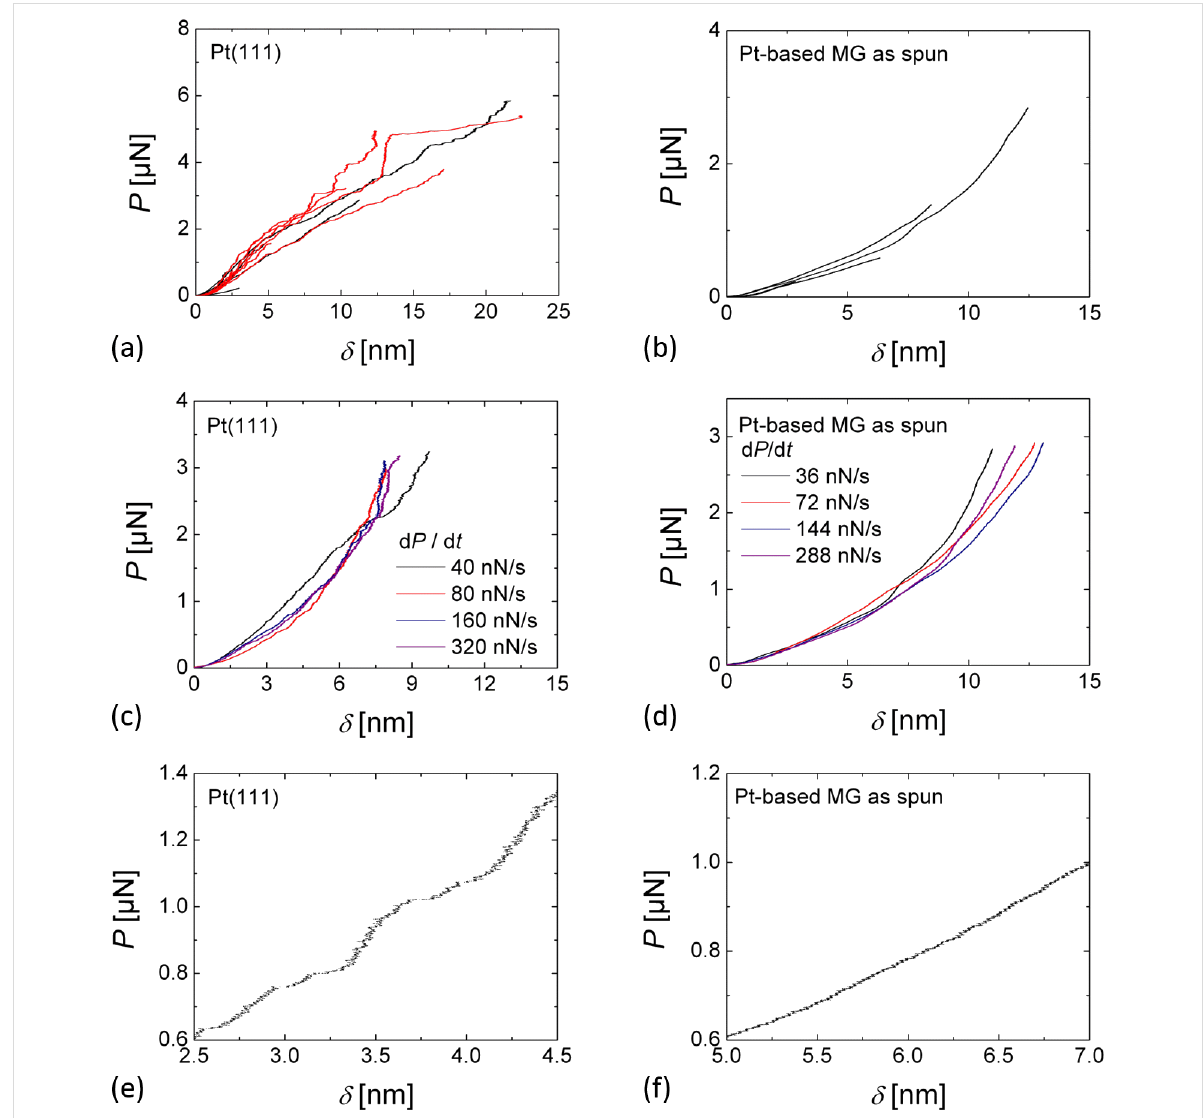
Figure 7: P – δ curves as a function of (a,b) the maximal load P max and (c,d) the loading-rate on (a,c) Pt(111) and (b,d) Pt 57.5 Cu 14.7 Ni 5.3 P 22.5 metallic glass; in (e,f) magnifications of P – δ curves at the plasticity on-set are shown for Pt(111) and Pt 57.5 Cu 14.7 Ni 5.3 P 22.5 metallic glass, respectively.